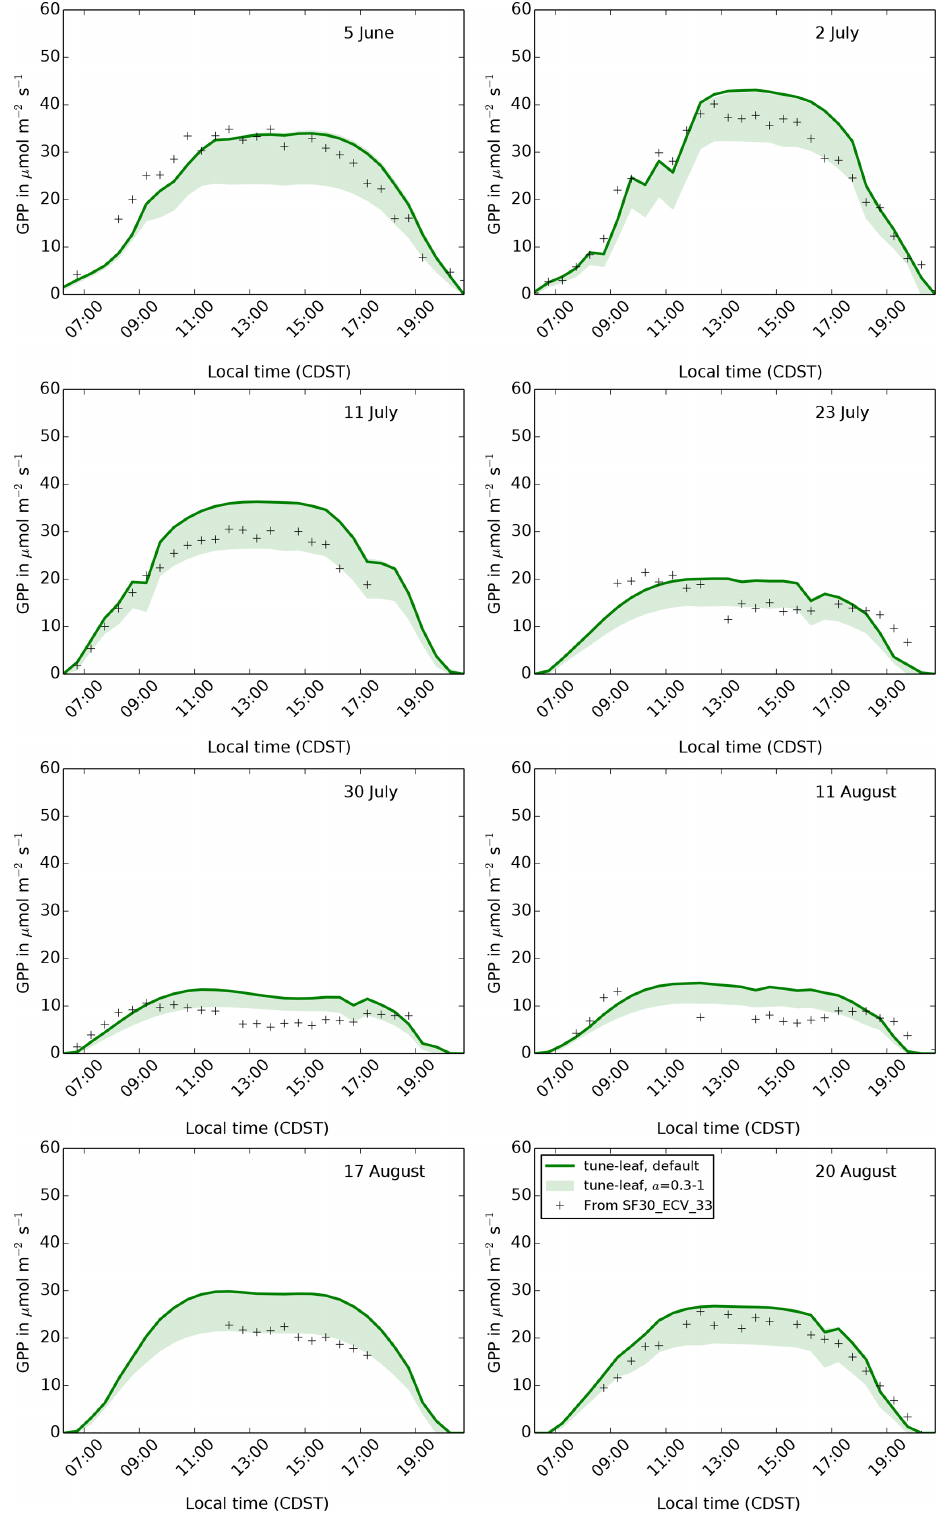
Figure 13. The diurnal cycle of GPP at site 4439 in the FIFE area for 8 days in 1987: 5 June (early growth), 2 and 11 July (peak growth), 23 July, 30 July and 11 August (dry period), and 17 and 20 August (early senescence). Green band shows how the tune-leaf simulation would vary for a canopy structure factor a in the range 0.3 to 1 (upper limit corresponds to a = 1, lower limit to a = 0 .